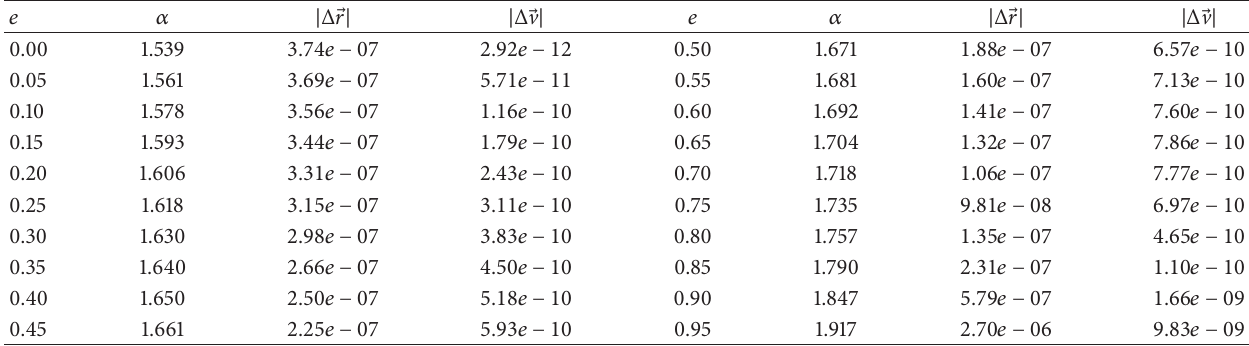
Figure 4: Local integration errors distribution 𝛼 = 2.0 . Table 2: Optimal 𝛼 for 𝑒 |Δ ⃗𝑟| in 10 −5 Km |Δ ⃗ V | and in 10 −8 Km / s.